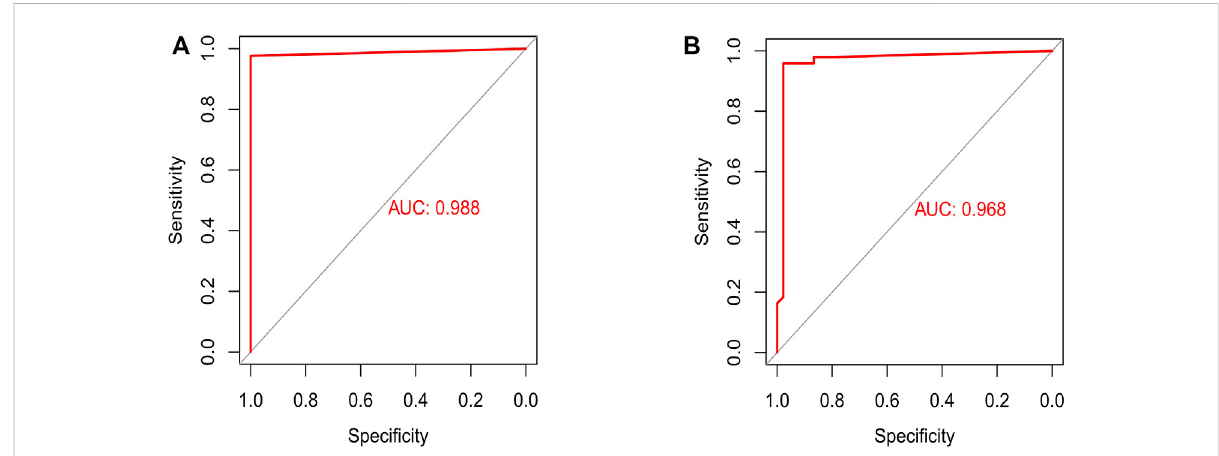
FIGURE 7 Assessment and testi fi cation of the ANN diagnostic model by the ROC curve. (A) The assessment result of the training set; (B) the testi fi cation result of the validation